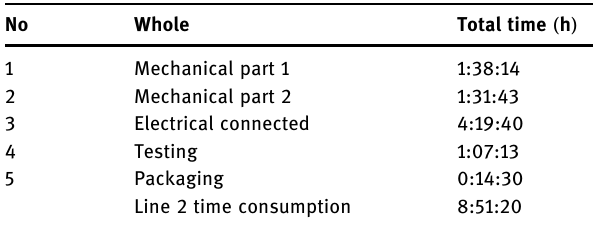
Table 1: Total optimized time consumption to produce platform